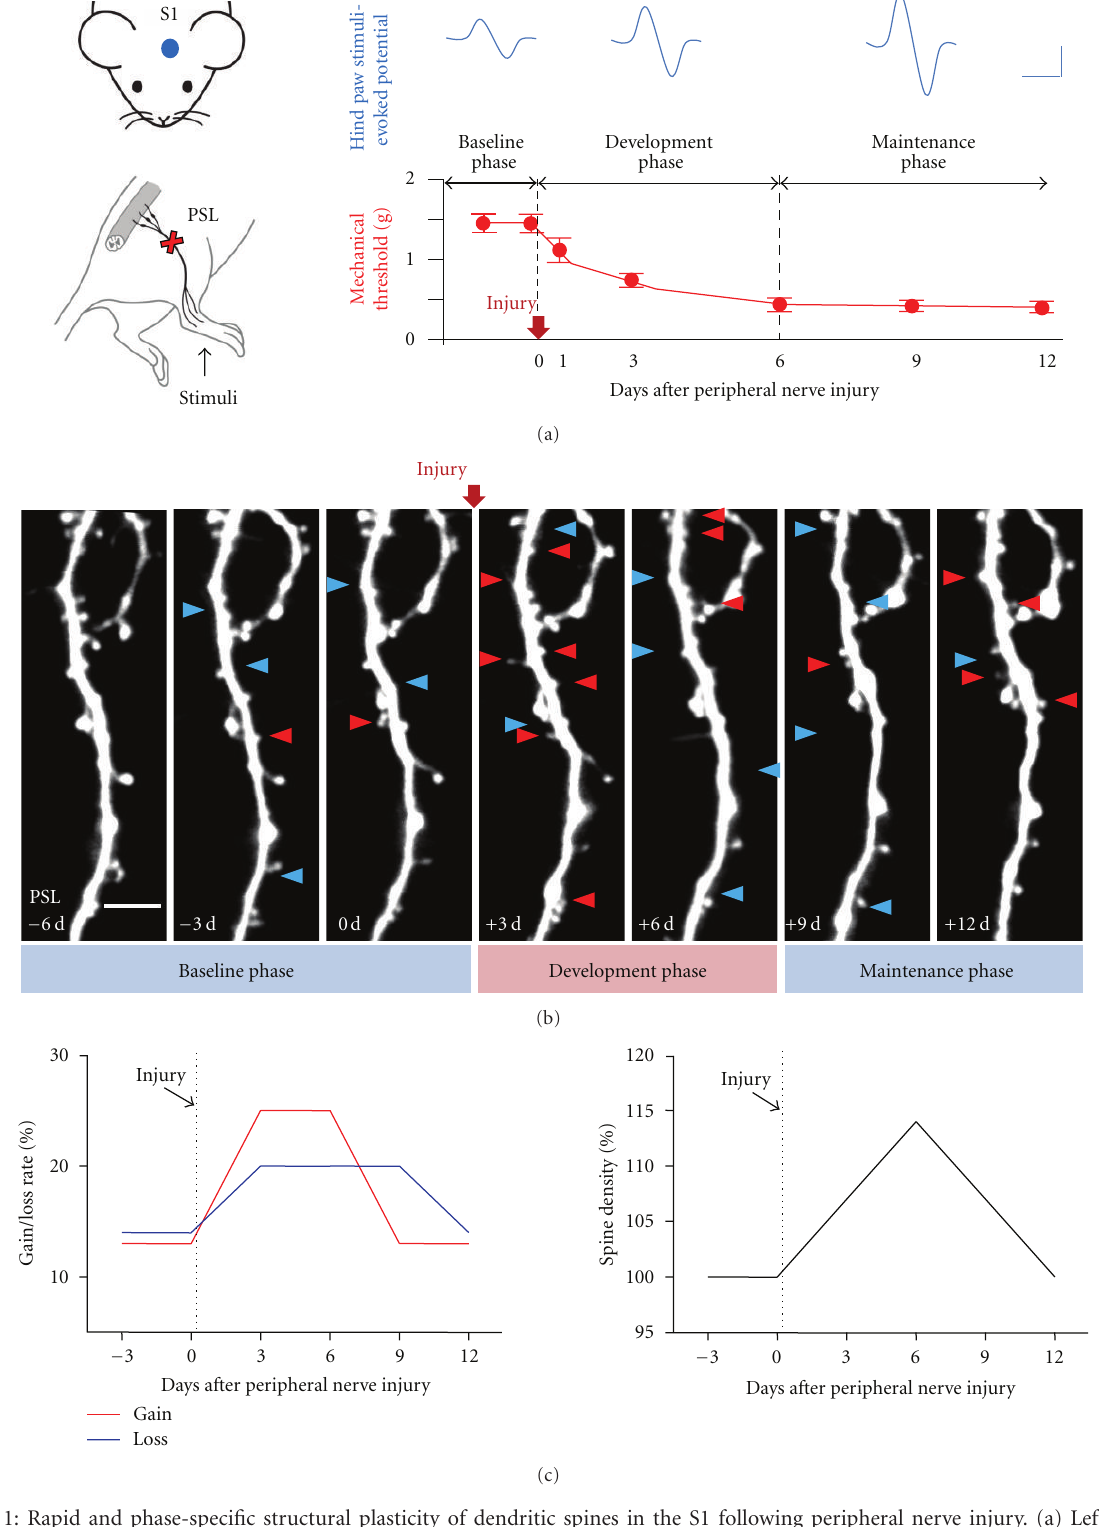
Figure 1: Rapid and phase-specific structural plasticity of dendritic spines in the S1 following peripheral nerve injury. (a) Left panels: schematic diagram of the PSL injury model and associated investigations in the S1. Bottom graph outlines the development and maintenance phases of mechanical allodynia following PSL injury with the upper panels showing the concurrent phase-dependent increases in somatosensory-evoked potentials in the S1. Scale bars, 50 ms (horizontal) and 50 µ V (vertical). (b) In vivo two-photon time-lapse images of the same S1 dendritic segment following PSL injury. Arrowheads indicate the spines that generated (red) and eliminated (blue) when compared with the previous imaging session. Scale bar, 5 µ m. (c) Schematic representation of the time course of changes in spine gain/loss rates (left) and overall spine density (right) during neuropathic pain. (a–c) Reproduced and adapted, with permission, from